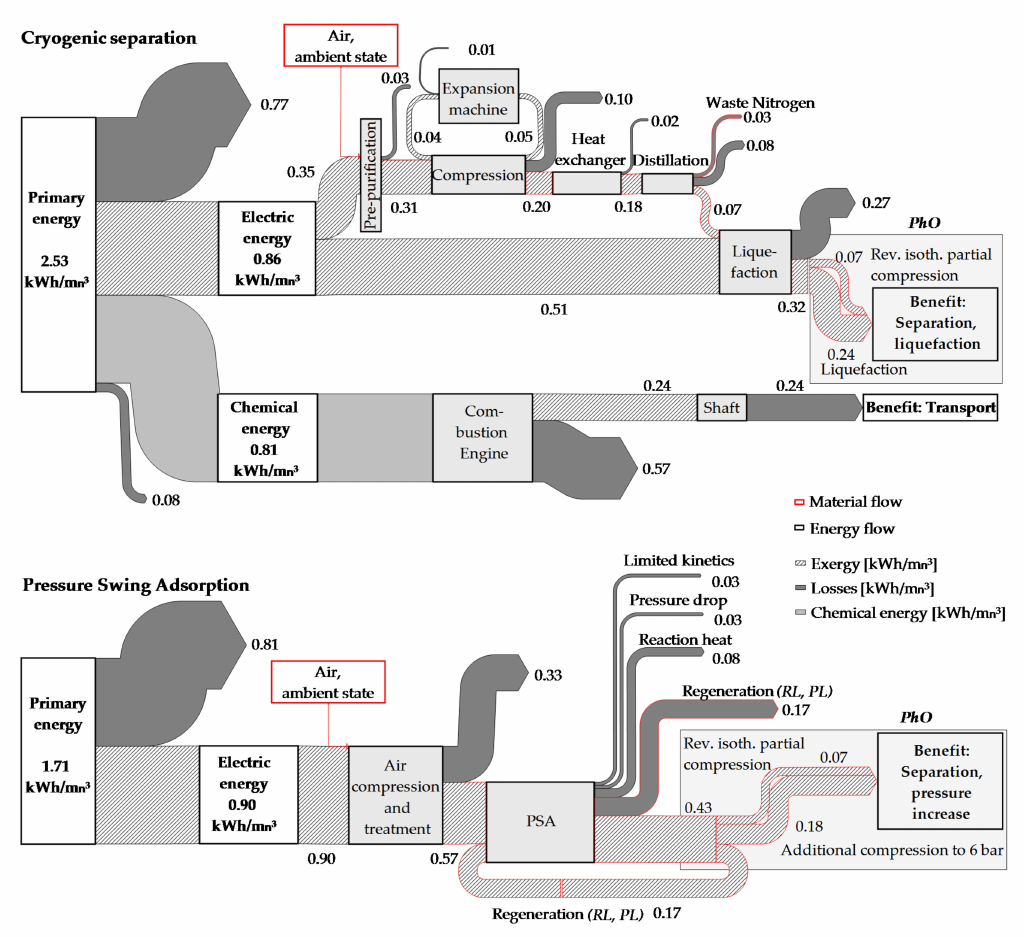
Figure 11. Comparison of oxygen production options with energy-flow